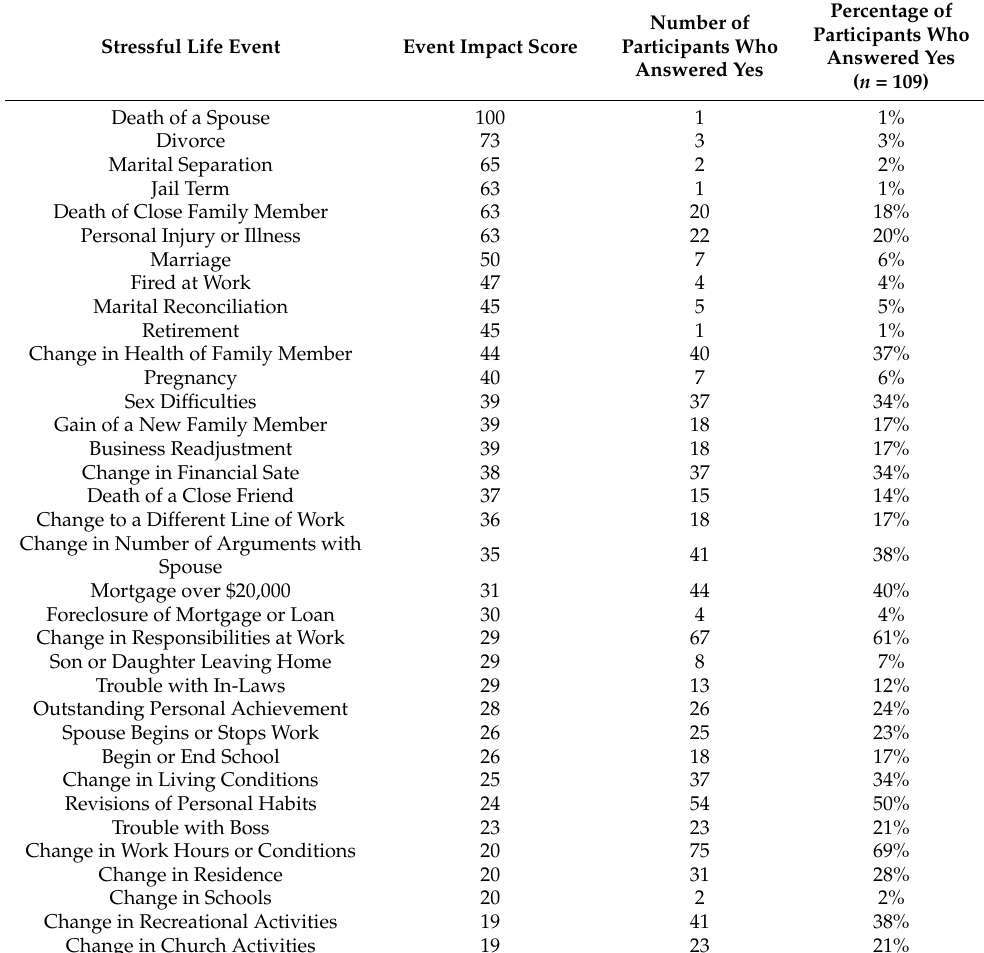
Table 3. Stressful life events reported by emergency department workers during the COVID-19